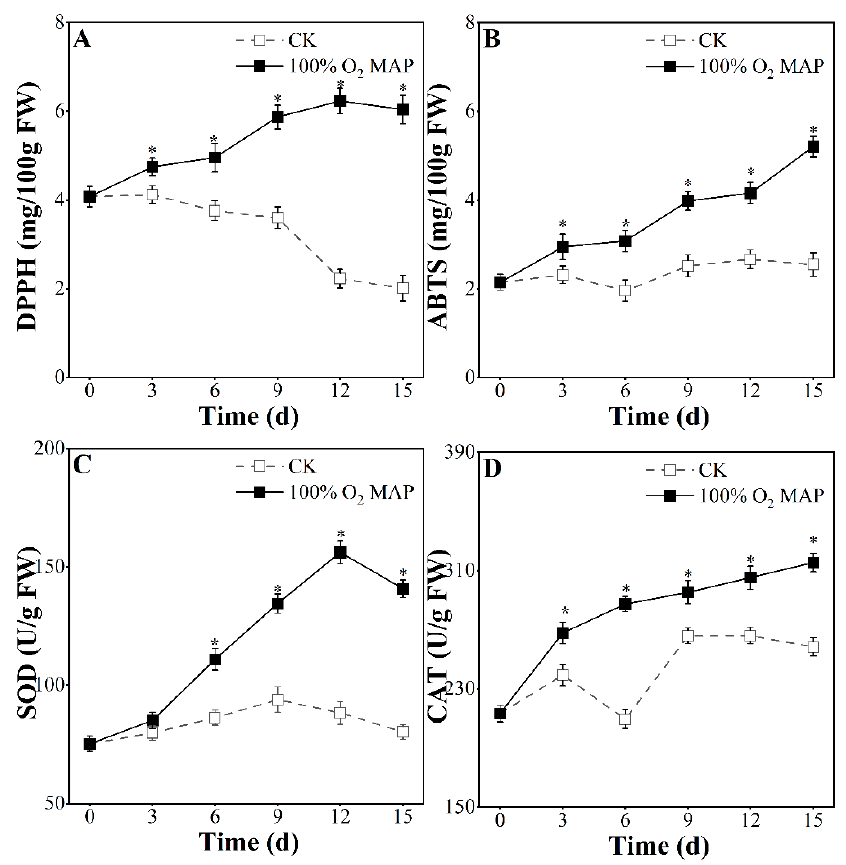
Figure 7. Effect of 100% O 2 MAP on DPPH ( A ), ABTS ( B ), SOD ( C ), and CAT ( D ) in fresh-cut broccoli. * in the figure indicates significant differences among treatments at the same storage time ( p <